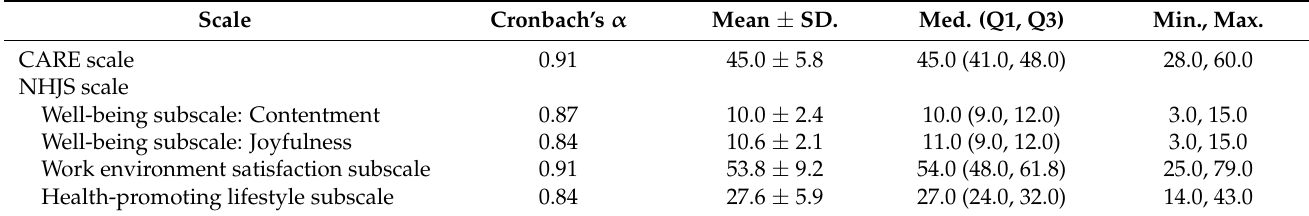
Table 2. Reliability coefficients and summary statistics of scale scores.